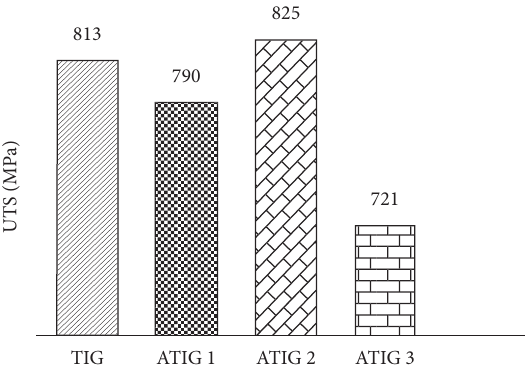
Figure 8: Ultimate tensile strength of TIG and ATIG welds. Table 13: Absorbed energy in HAZ for ATIG